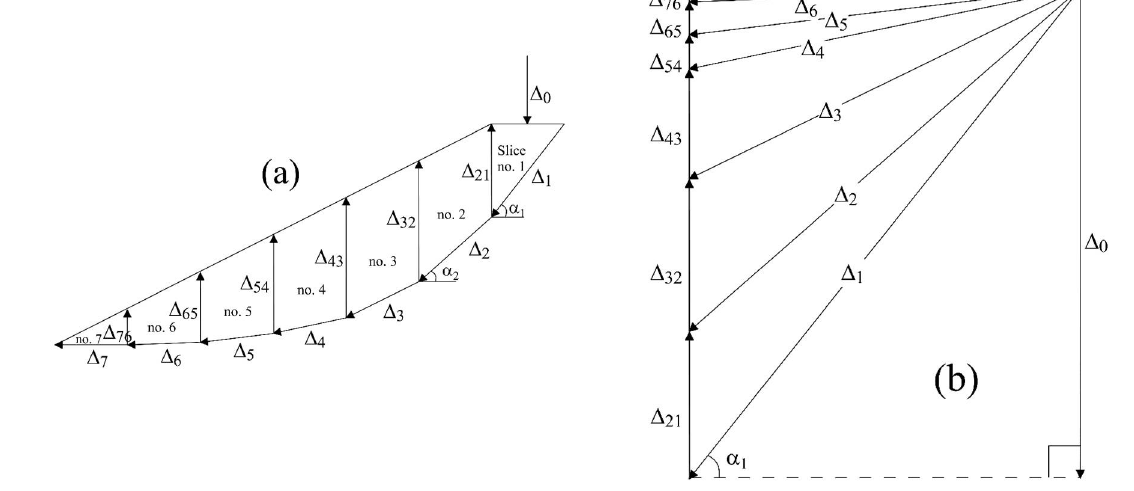
Figure 10. ( a ) Vector of displacements along failure surface and inter-slice faces for Ψ = 0 and ( b ) Hodogram for Ψ = 0.